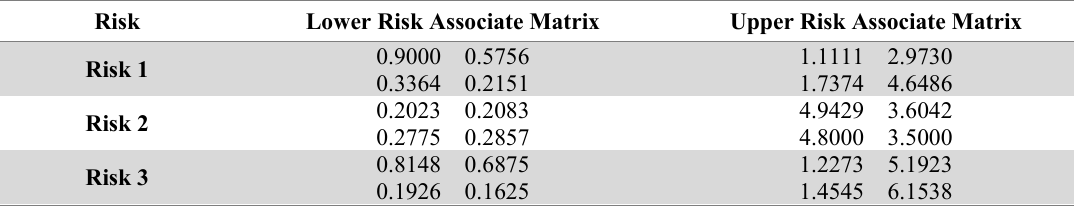
Risk Associate Matrix